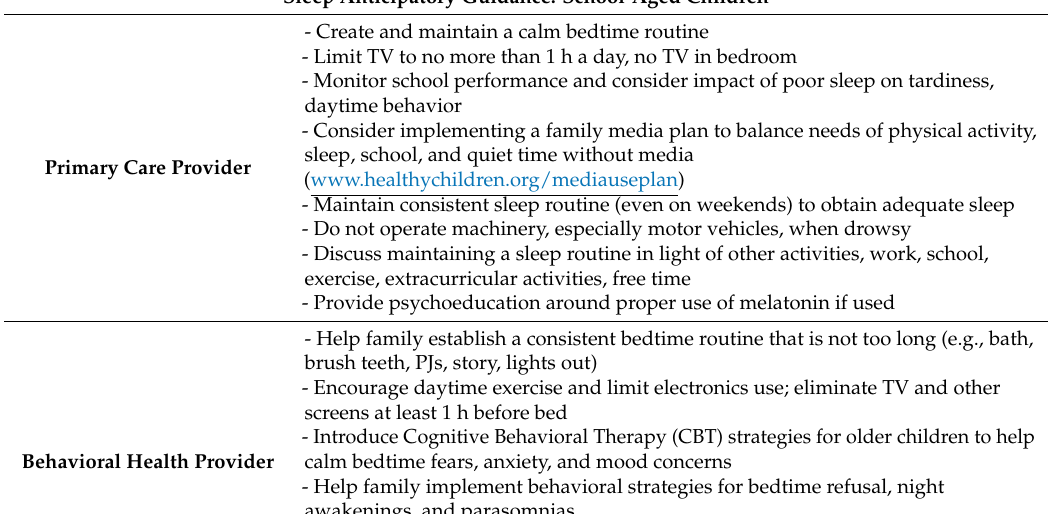
Sleep Anticipatory Guidance: School-Aged